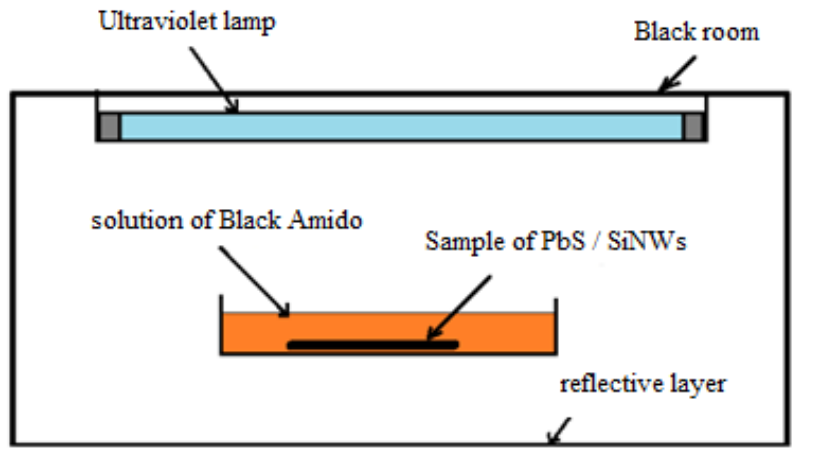
Figure 9 . Photochemical reactor . Figure 9. Photochemical reactor.